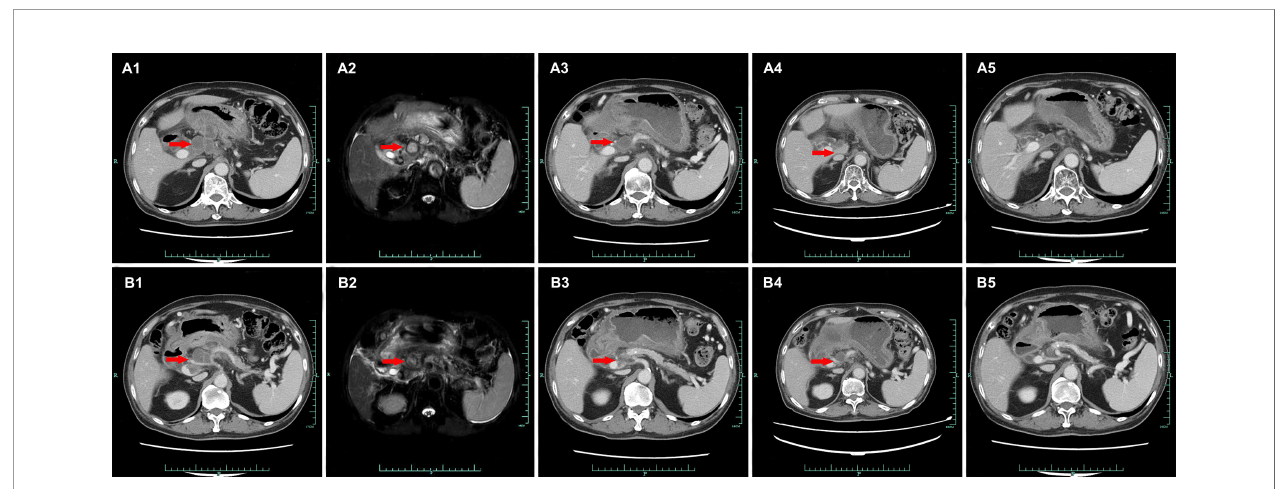
FIGURE 2 | Abdominal CT presentations after recurrence (from July 11, 2020 to August 4, 2021, red arrows for tumors). ( A1/B1 ) July 11, 2020. ( A2/B2 ) October 22, 2020. ( A3/B3 ) January 25, 2021. ( A4/B4 ) April 6, 2021. ( A5/B5 ) August 4,